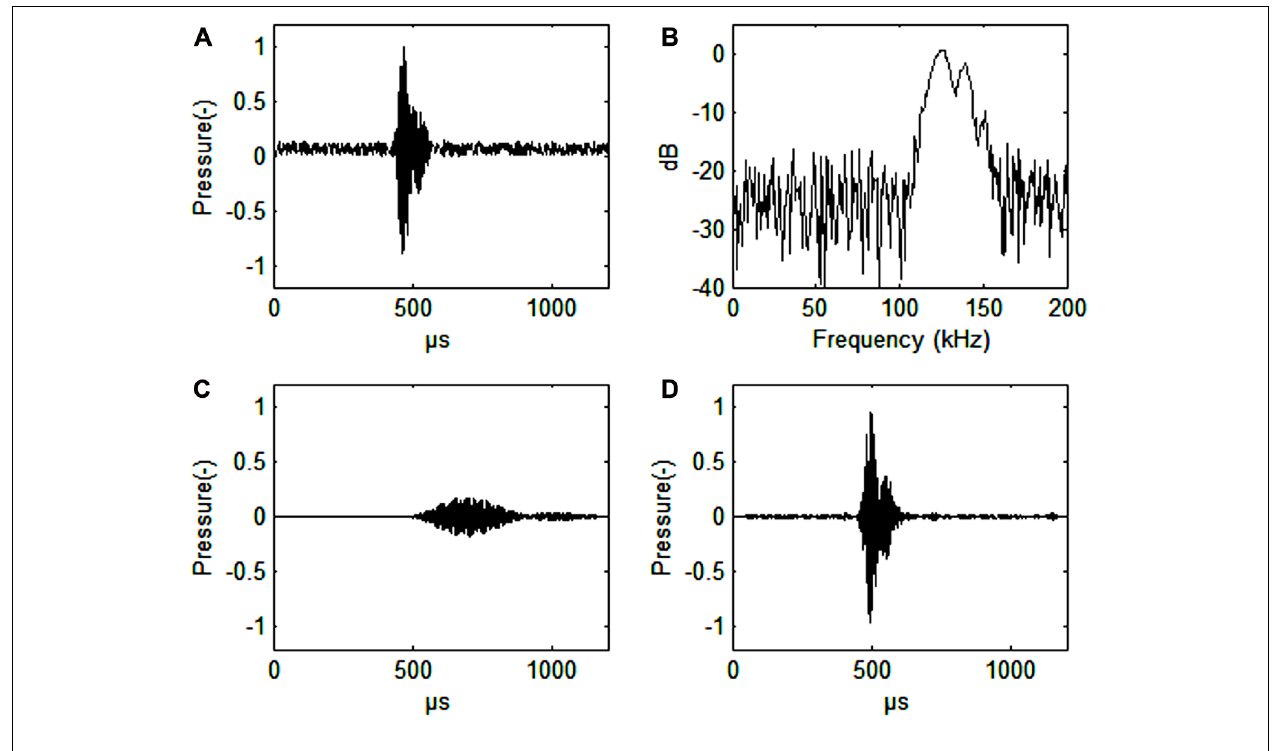
simulated third-octave band filter (center frequency 130 kHz, bandwidth 30 kHz, 4th order Butterworth filter). Note the vastly improved time resolution that is only about 10 μ s delayed relative to the timing of the original signal (A) . Also note the improved signal to noise ratio (34 dB) in C relative to the third-octave filtered signal (30 dB) in